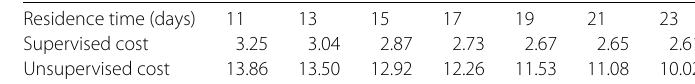
Table 1 Comparison of supervised and unsupervised costs over 650